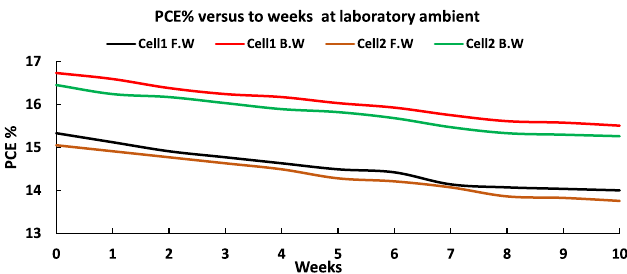
Fig. 9. Variations in the ef fi ciency of the perovskite solar cells measured over 70 days period in weekly intervals. Devices were kept in laboratory